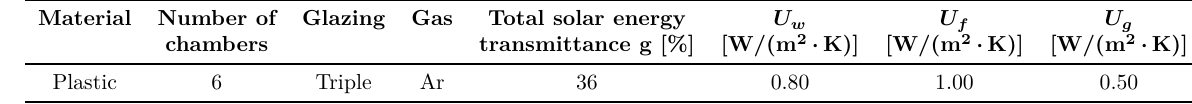
Table 1. Properties of the measured plastic window given by the